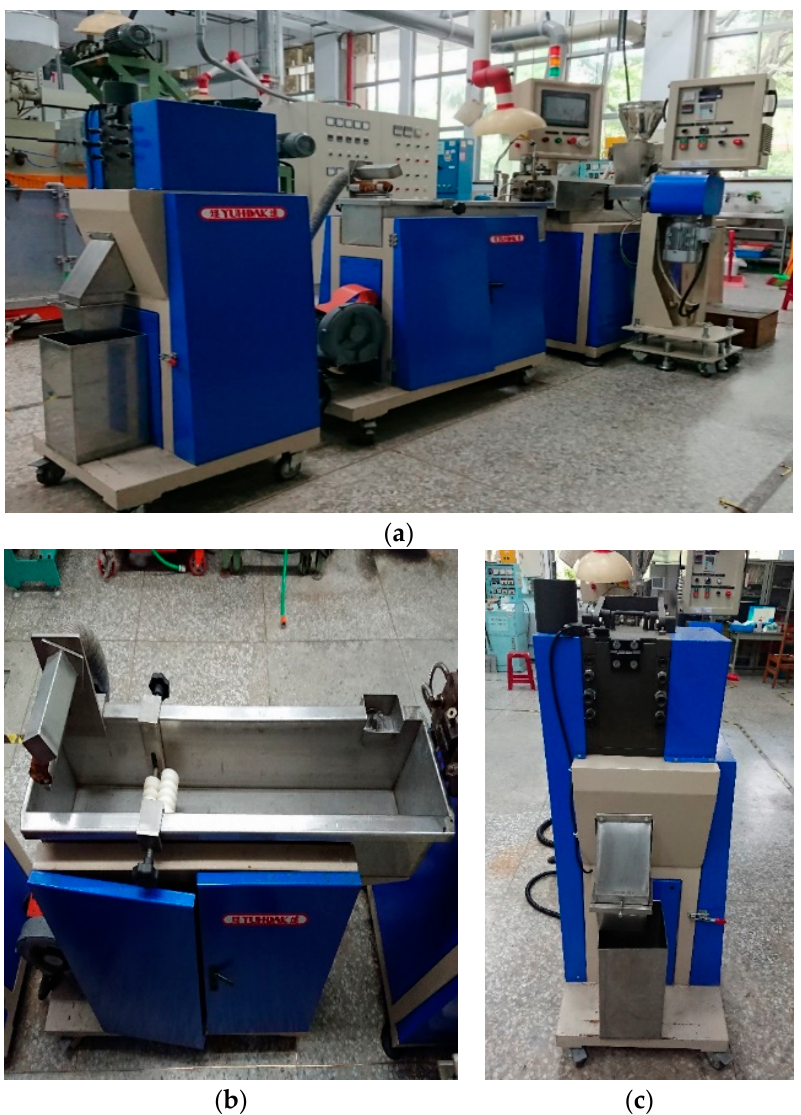
Figure 7. Twin screw mixer: ( a ) Melting and heating zone. ( b ) Water immersion cooling zone. ( c ) Pelletizing and collecting area.